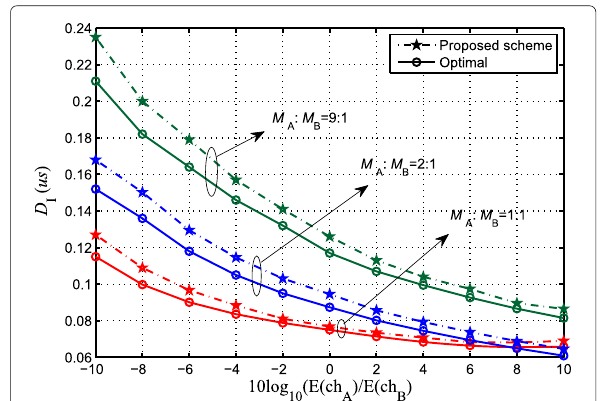
Fig. 4 D I performance comparison of optimal and proposed suboptimal algorithms